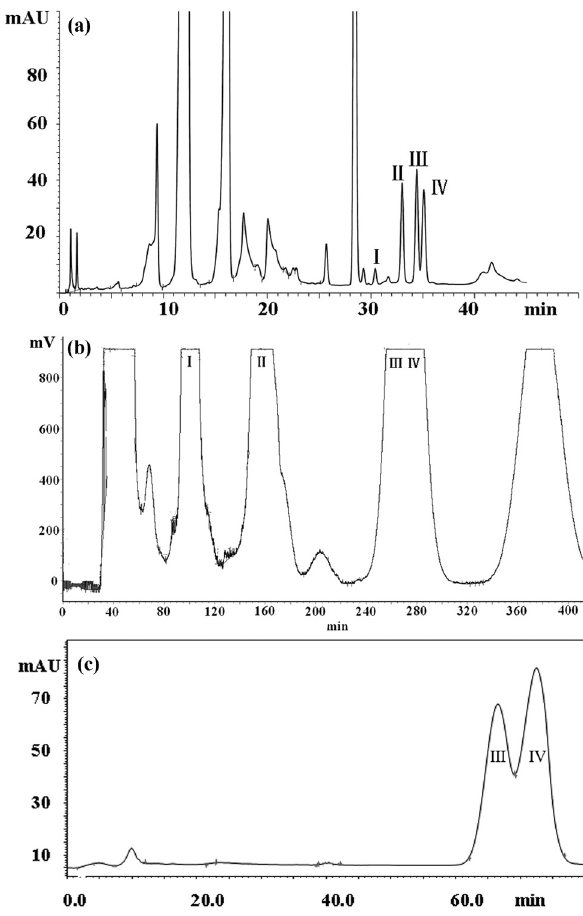
purity of the two substances was 98.9 and 98.3%, respectively. Data of 1 H NMR and 13 C NMR obtained in this study were compared with those of the published literature [ 32,33 ] , and the four fractions were identi fi ed ( Figure 4 ) . The spectroscopic data for each compound are as follows.